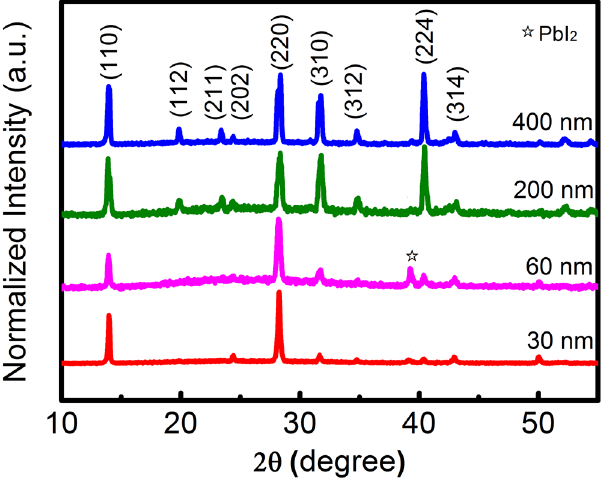
Figure 2. Comparison of XRD patterns of the perovskite films on AAO templates with different pores in under the same condition mentioned above and the second is prepared by dipping the AAO templates in the same solution for 2 hours instead of the spin-casting method. The XRD patterns show the same results in the first batch of films (Fig. S4b). And the XRD patterns of the second batch of films show ultra-strong diffraction peak of PbI 2 for all films and it is still stronger for CH 3 NH 3 PbI 3 film on AAO template with d po re = 60 nm than others (Fig. S4c). So we deduce that this phenomenon might come from the porous structure and is related to the ratio between pore and grain sizes. Figure 3a presents the UV-vis absorption spectrum of CH 3 NH 3 PbI 3 films. High absorbance is obtained in the visible region for all the films on AAO templates. The absorption spectrum of the pure AAO templates is shown in Fig. S5. The pure AAO templates exhibit low absorption, indicating the high absorbance originates from CH 3 NH 3 PbI 3 films. According to the absorption coefficient, a tauc plot of ( α h ν ) 2 - h ν is used to determine the opti- cal band gap, as shown in Fig. 3b. And the relationship between d pore and optical band gap is described in Fig. 3c. The optical band gap is increased from 1.536 eV to 1.618 eV with decreasing d pore of AAO templates from 400 nm to 30 nm. Thus an obvious 0.082 eV blue shift of optical band gap is produced. In addition, the Urbach energy of the CH 3 NH 3 PbI 3 films can be obtained by fitting the absorbance curve at the optical band edge using an empirical equation 22 . As shown in Fig. 3c, the Urbach energy is proportional to the d pore of AAO templates. It is known that Urbach energy is a characterization of structural disorder in the materials and higher Urbach energy is related to higher disorder. Hence, it indicates larger pores of AAO templates lead to higher disorder in CH 3 NH 3 PbI 3 films. In general, there are two mechanisms giving rise to the blue shift, including the doping effect and the quantum size effect. Obviously, the doping effect can be excluded in our work. Then the quantum size effect generally would affect the band gap. However, Bohr radius of CH 3 NH 3 PbI 3 films is about 2.2 nm calculated from the mag- netoabsorption spectrum 23 , and the minimum grain size obtained from the SEM patterns in our work is ~40 nm on AAO template with d pore = 30 nm. Thus the contribution of quantum size effect to the blue shift of our films is negligible, which is completely different from the results investigated by Demchyshyn et al . 19 . Thereby, based on finite element modeling, we carry out the investigation on numerical simulations to represent the absorption fea- ture in wavelength range from 700 to 780 nm. The model is shown in Fig. 4a. The main physical parameters of t in , t top , d denote the thickness of films adhered on the inwall of the pore, the thickness of films deposited on AAO top surface, and the wall thickness of AAO, respectively. These values are estimated from the SEM images for different cases, and increasing t in and decreasing t top are set with increasing the d pore of AAO templates (Table S1). By con- sidering the higher order degree of the top surface and the capability of the computer, the height of AAO template is set as 1 μ m. Simulation results are shown in Fig. 4b. It is clear that the whole tendency of the absorption curve agrees well with the experimental data. While the degree of the blue shift is smaller than the experimental value, which seems to result from the dielectric constant of single crystal is used in our calculation 24 . When the pore size is small and the period is short, the dispersive relationship of the structure can be equaled as a homogeneous material based on Maxwell-Garnett effective medium method. The absorption behavior can be calculated by Snell’s low 25 . For the long period, the model can be regarded as a dielectric waveguide 26 . The cutoff wavelength is in direct proportion to the d pore . Thus, the absorption edge is blue-shifted as the d pore decreases. In additional, the minimal absorbances are different. It is because that the probability of photons coming into the waveguide becomes larger as the d pore increases. The incoming photons are absorbed during propagation in the pore. Figure 5a presents the photoluminescence (PL) spectrum of CH 3 NH 3 PbI 3 films on AAO templates with different pore diameters with a constant excitation intensity of 0.3 μ W. The PL peaks as shown in Fig. 5b are consistent with that of the UV-vis peaks in Fig. 3b, which has a 14 nm blue-shift from 775 nm to 761 nm with decreasing d pore of AAO templates. The PL intensity exceeds 10 4 counts with the excitation intensity less than 1 μ W. Moreover, the PL intensities are increased with increasing pore diameters of AAO templates. To further